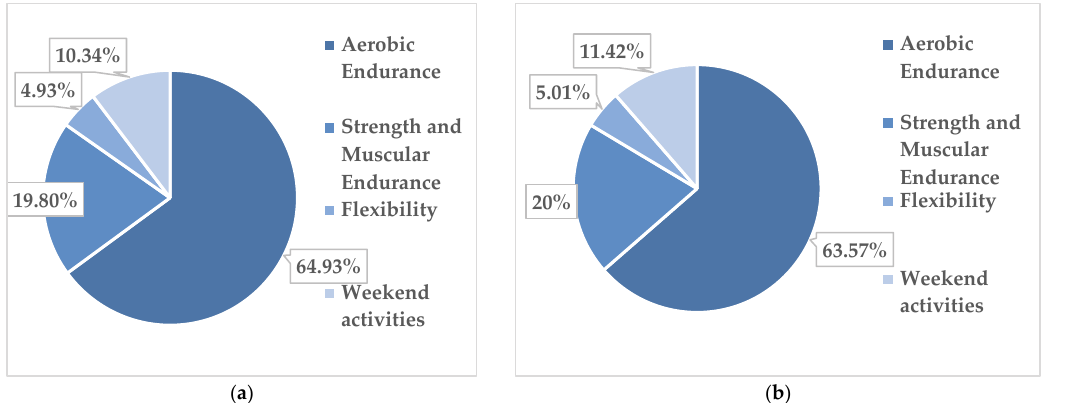
Figure 6. Frequency of preferred activities/module in the physical activity programme in over ‐ weight girls ( a ), overweight boys ( b ).